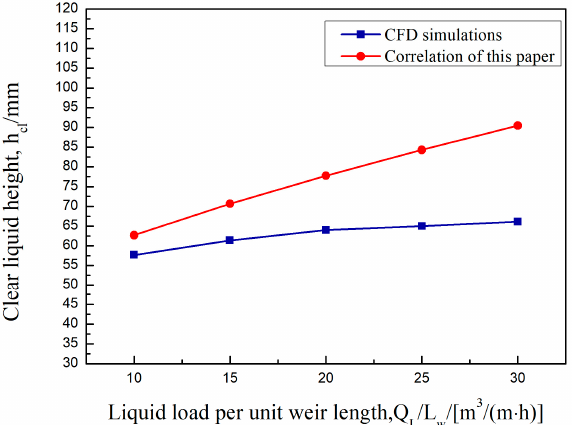
Figure 6. Clear liquid height as a function of the liquid load per weir length. U S = 0.65 m/s, h W = 0.054 m.